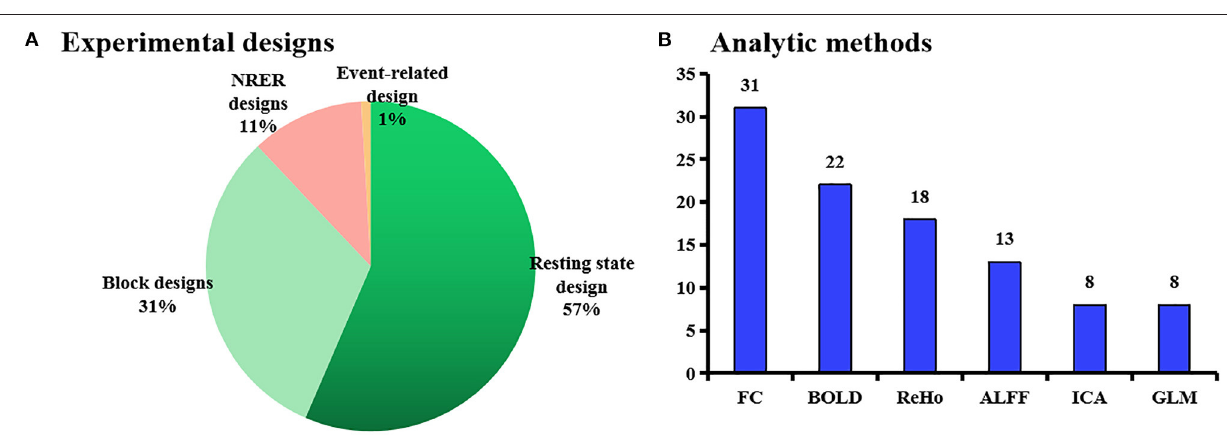
FIGURE 4 | (A) Proportion of experimental designs in the reviewed studies. (B) Analytical methods used in the reviewed studies. ALFF, the amplitude of low-frequency fluctuation; BOLD, blood oxygen level-dependent; FC, functional connectivity; ICA, independent component analysis; GLM, general linear model, NRER, non-repeated